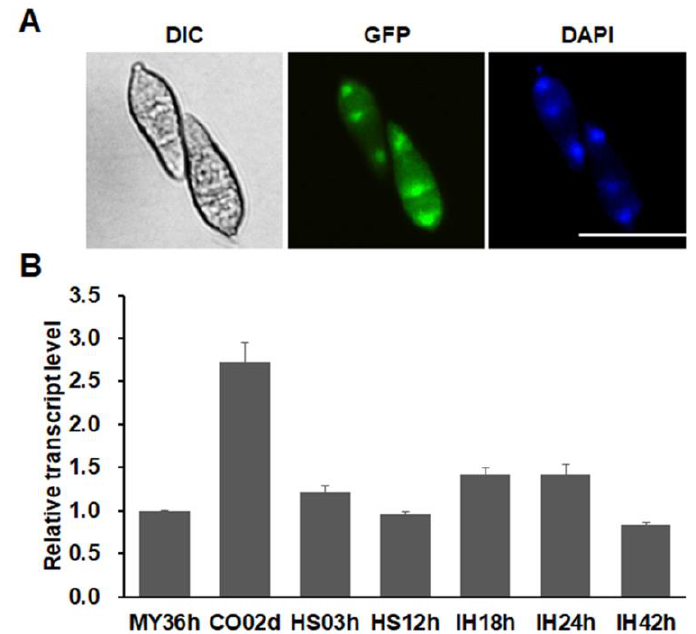
Figure 4. Expression pattern and subcellular localization of MoSnf5. ( A ) Nuclear localization in conidia of a strain expressing the MoSnf5-GFP fusion under the control of a constitutive promoter RP27. DAPI was used to stain the nuclei as a control. Bar, 20 μm. ( B ) The expression levels of MoSNF5 in vegetative hyphae (HY), conidia (CO), mature appressoria (AP12h), and invasive hyphae (IH48h) were evaluated by q RT-qPCR. Relative abundance of MoSNF5 transcripts during different developmental stages was normalized by comparing with HY, which was set as 1. Three independent biological replications, each with three technical replicates, were performed.